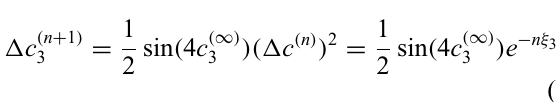
TABLE I. Convergence to dual unitaries for different two-qubit seed unitaries, parametrized by the Cartan coefficients c ( 0 ) cases, c ( ∞ ) 1 Cartan coefficients and Dual-unitary Nature of Weyl-chamber location of seeds approached